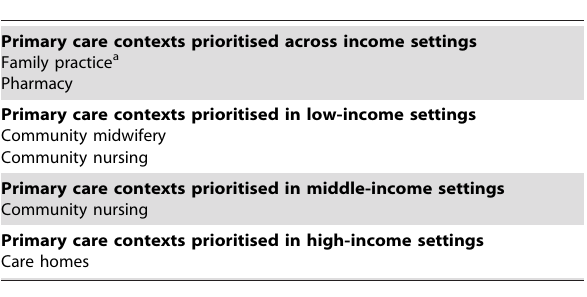
Table 4. Five key causes of patient safety incidents that required further study across countries with different levels of